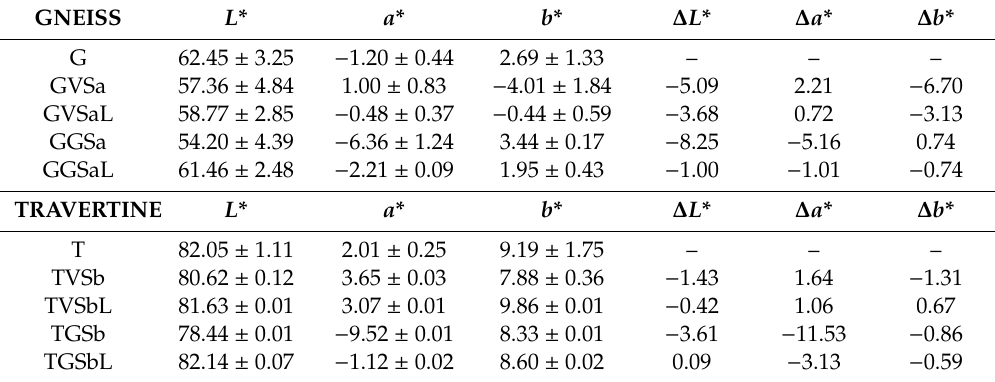
Table 4. Mean values and standard deviation values of color coordinates L *, a *, and b * for gneiss and travertine surfaces (respectively for the reference stones and the surfaces after each cleaning treatment tested in this research for the removal of the violet and green paints). Moreover, the colorimetric di ff erences are also shown, considering the color of the surfaces before to be painted as the reference color. Check Table 3 for sample